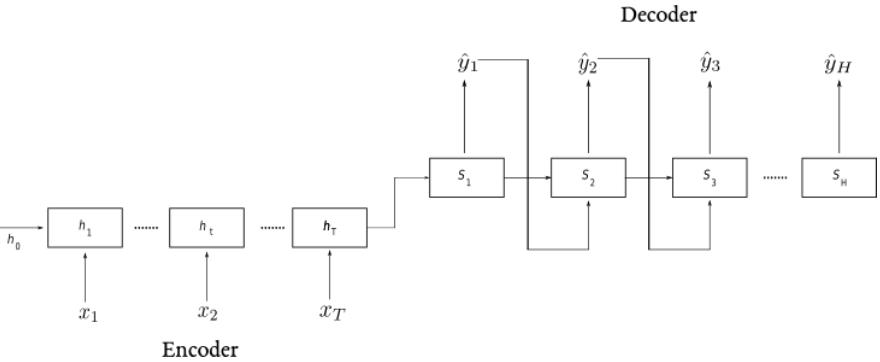
Figure 2. Sequence-to-sequence RNN